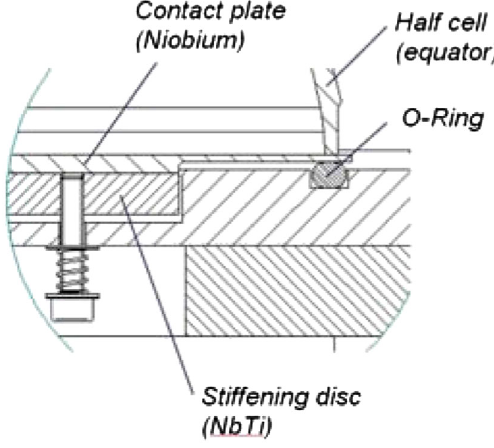
FIG. 10. Detail view of the contact area.